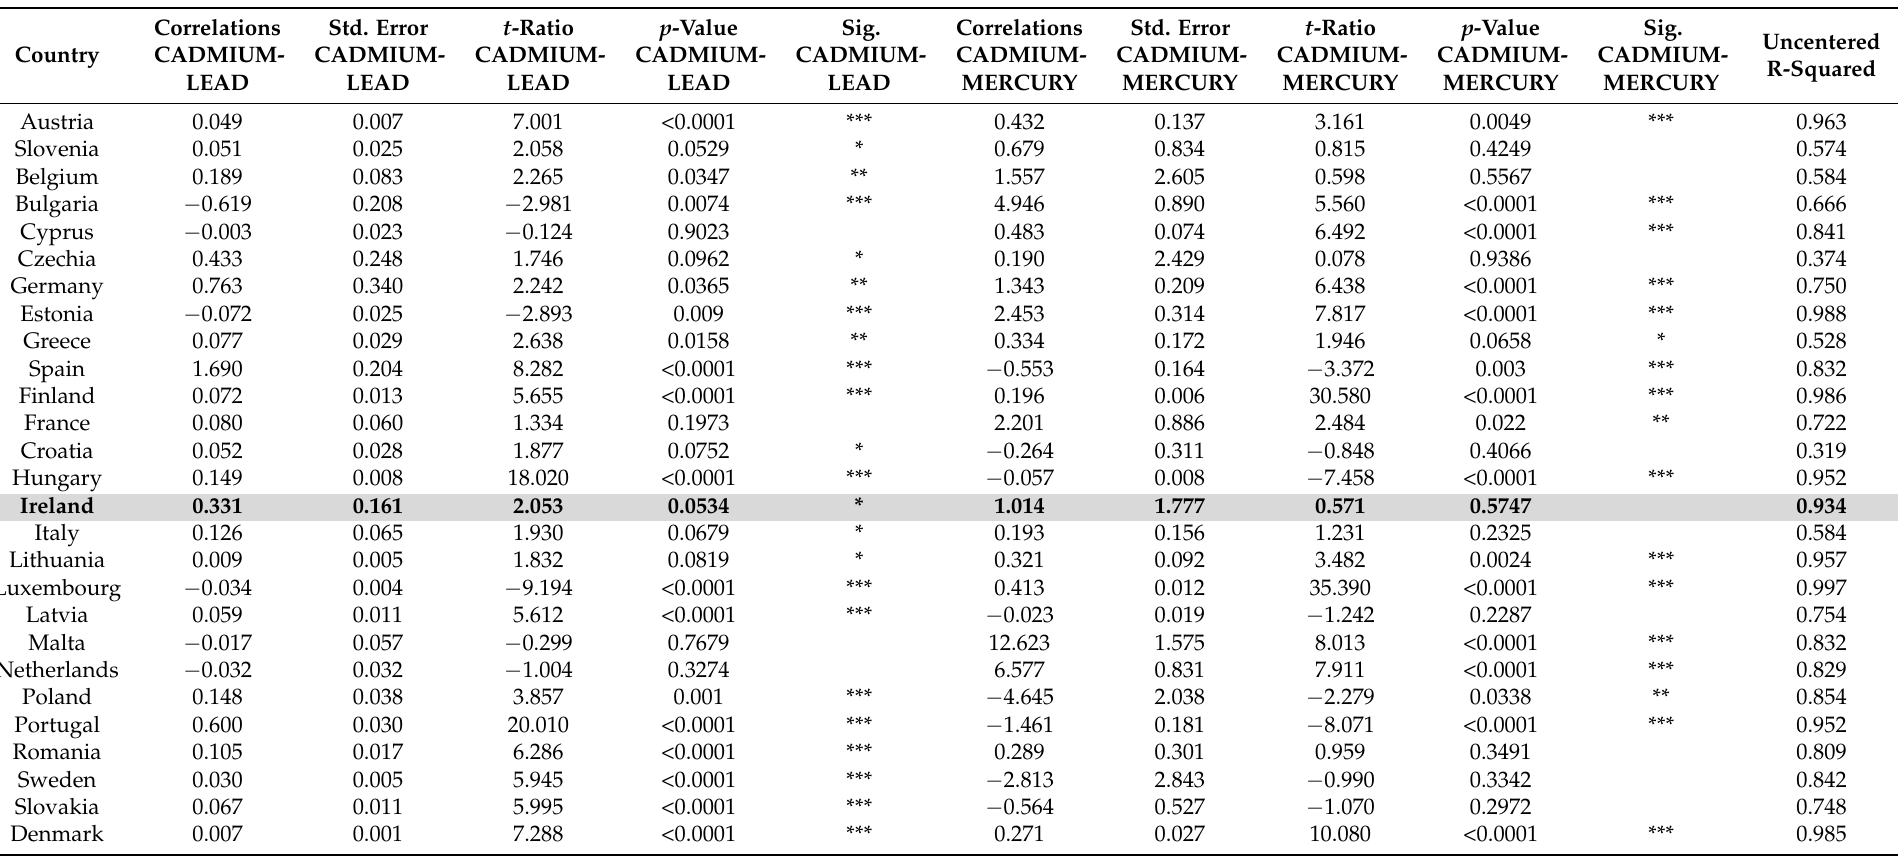
Table 2. Results of econometric correlations of spatio-temporal heavy metal pollution at Member State